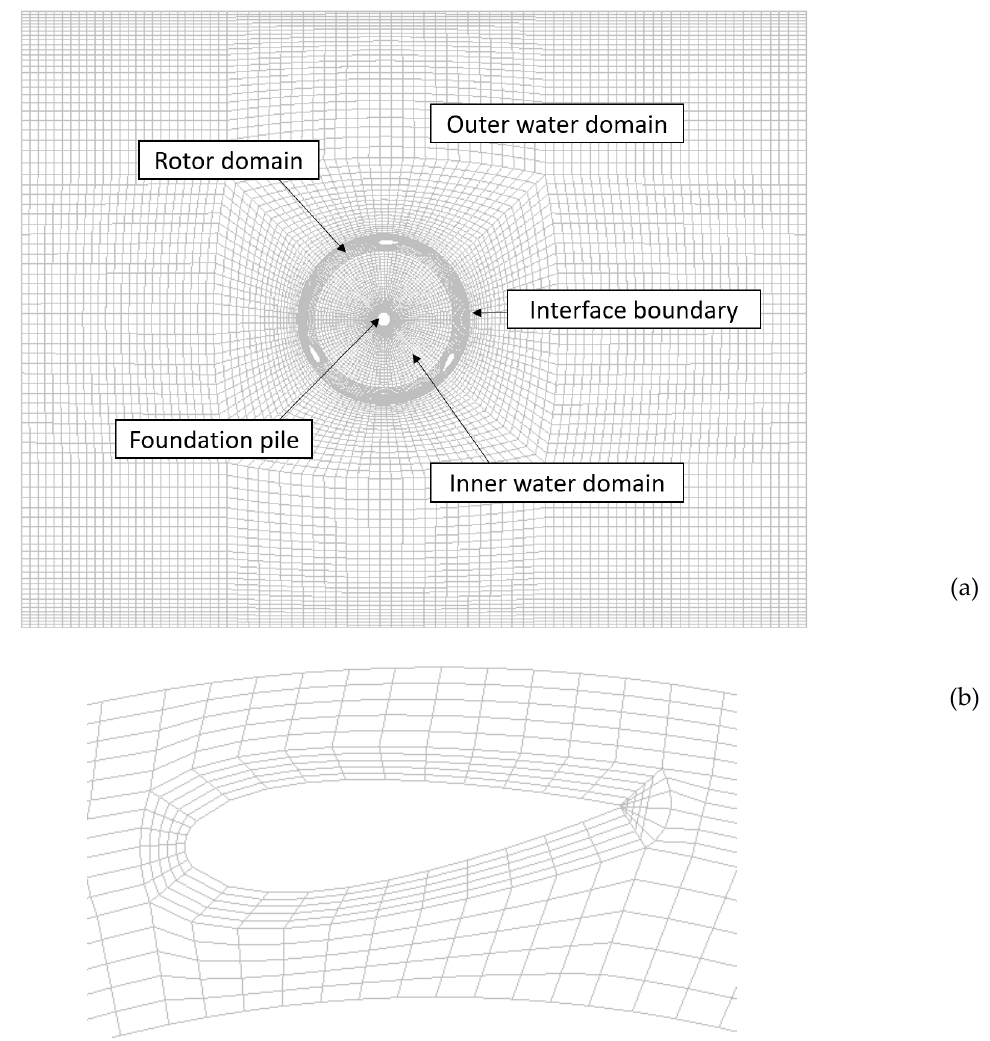
Figure 4. Computational grids around turbine rotor: ( a ) structured mesh grids at section surface z = 1.0 H ; ( b ) refined mesh close to rotor wall.